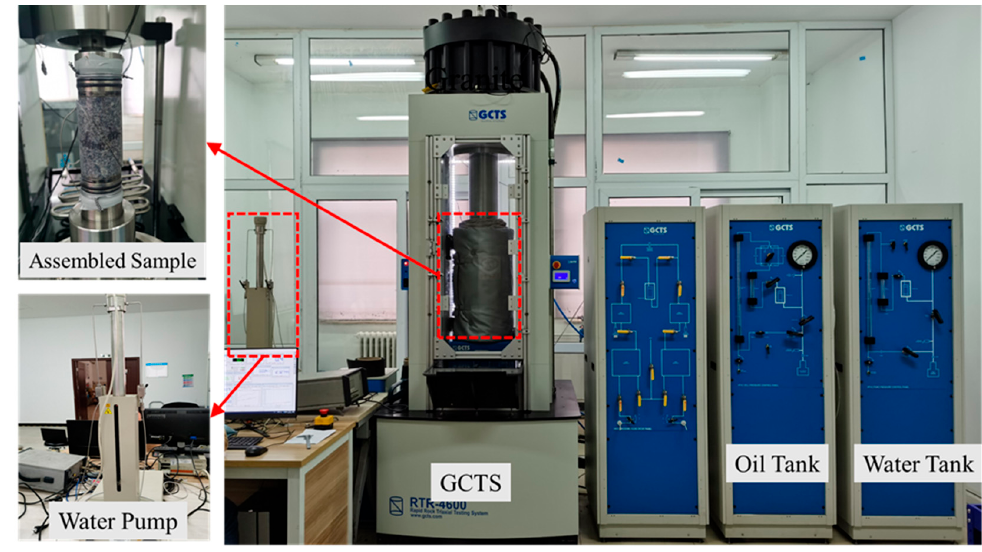
Figure 3. The experimental setup of the HM-coupling shearing test.